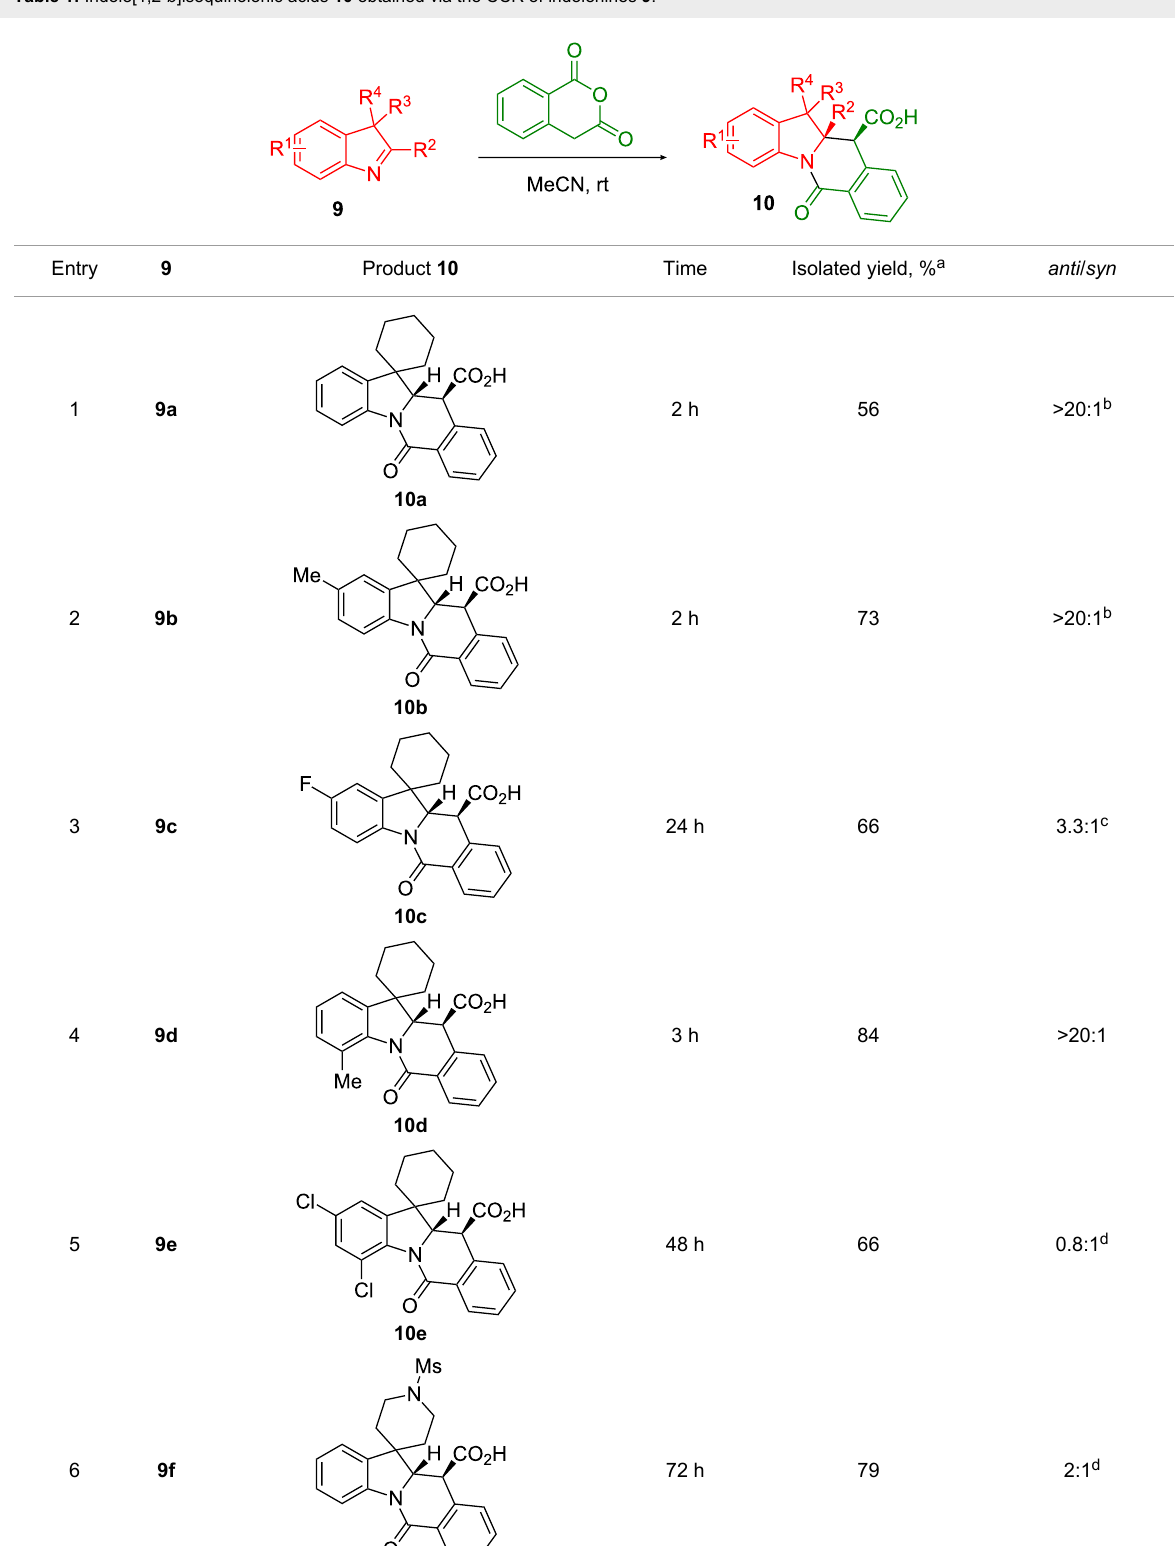
Table 1: Indolo[1,2- b ]isoquinolonic acids 10 obtained via the CCR of indolenines 9